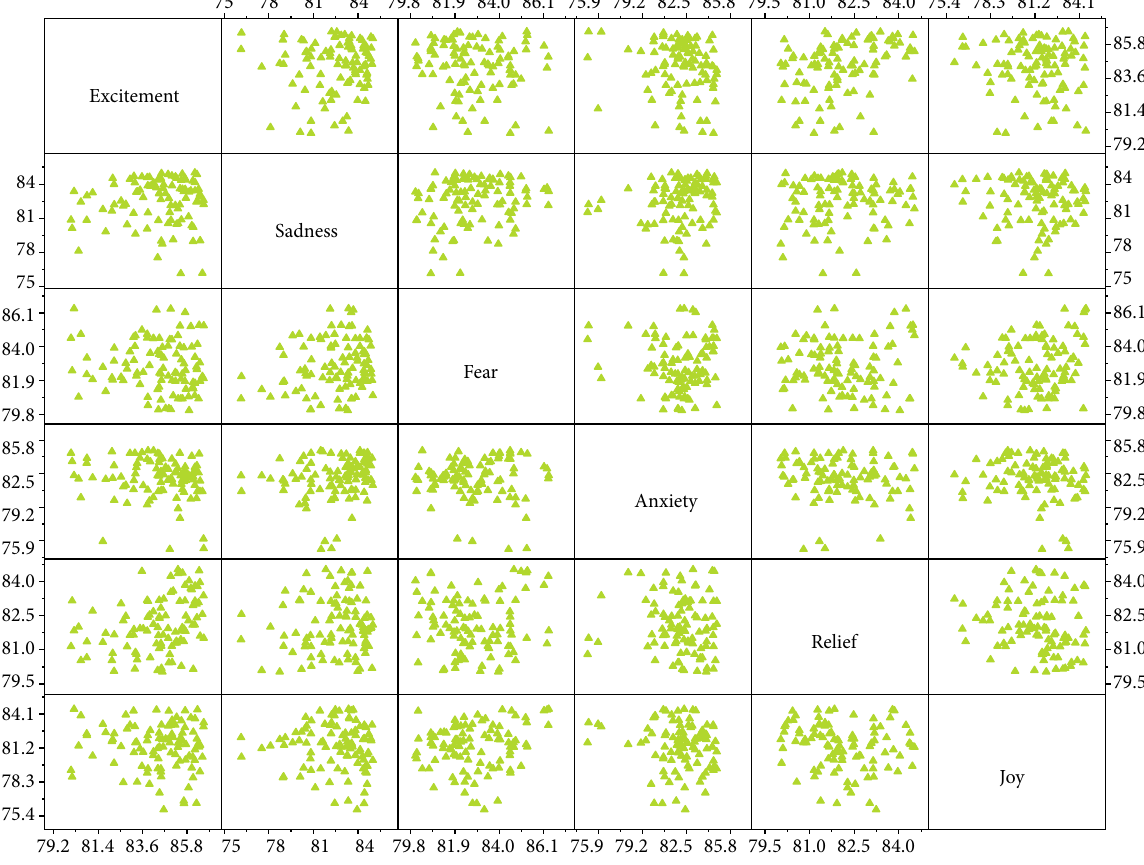
Figure 5: Graph of recognition rate of semantic matching